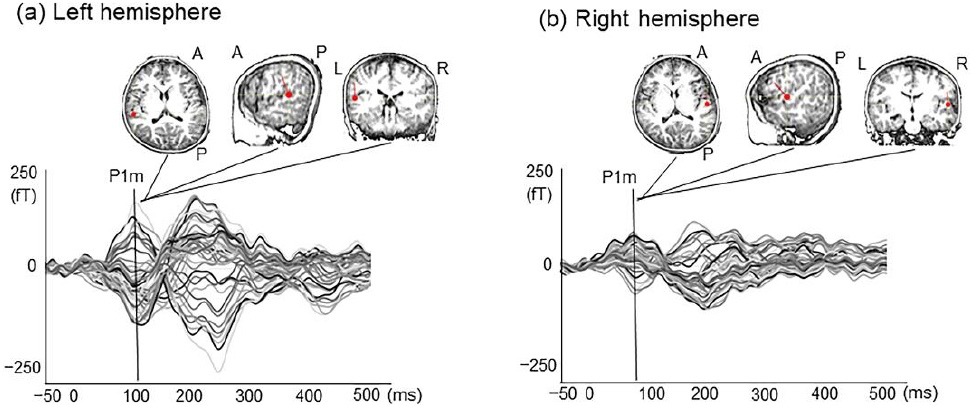
Figure 1. Source modeling of P1m responses evoked by tone stimuli from a 5-year-old male with TD. AEF waveform and dipole location of P1m response in both Heschel’s gyri in a child. The P1m response showed an activity peak at 70–150 ms in the left hemisphere ( a ) and the right hemisphere ( b ). Red arrows indicate the directions of equivalent current dipole orientation. A, anterior; P, posterior; L, left; R, right.